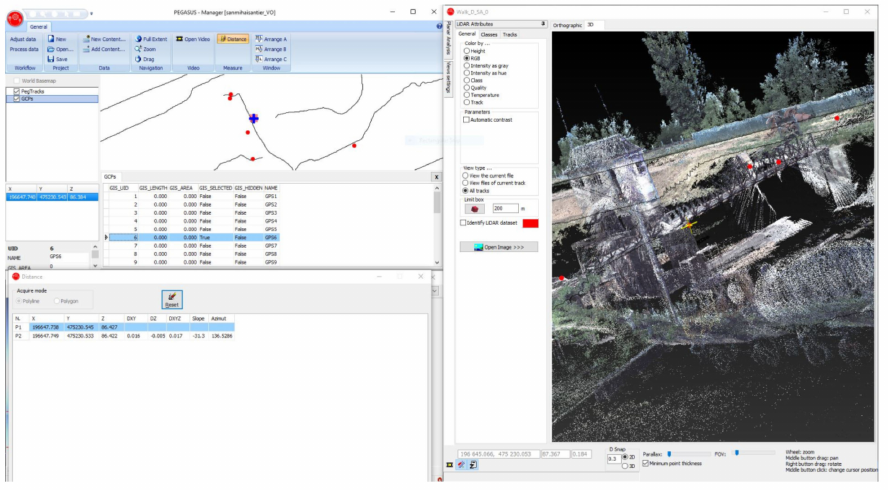
Figure 11. Presentation of errors for the measurements performed. Table 5 presents the data entered in the processing software. In Tables 6 and 7, we can see the fulfillment or non-fulfilment of ambiguities as well as the accuracies obtained. Table 5. Raw data entered in LGO, Topolov ă ¸tu Mic with corrected stations.